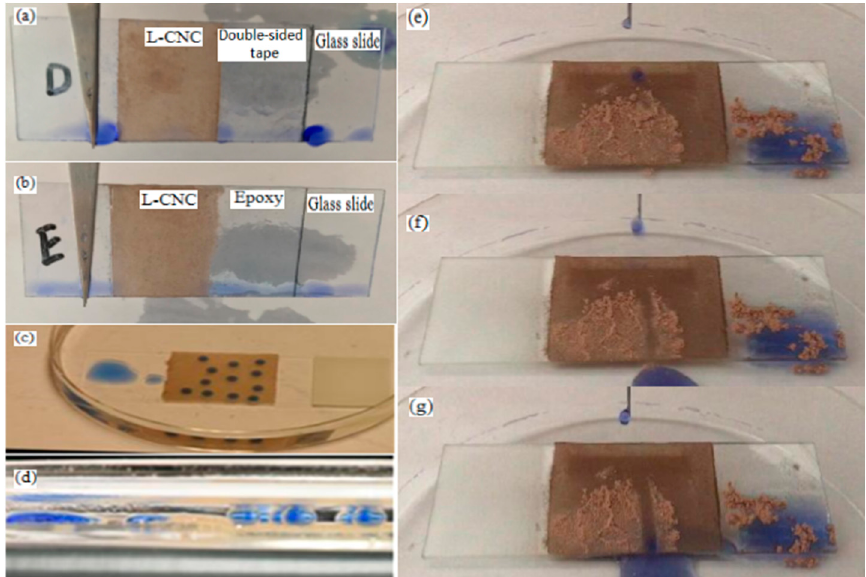
Figure 4. Water repellence properties of ( a ) the D and ( b ) the E coatings; status of the water droplets on the untreated glass slide and the glass slide treated with the D coating from ( c ) a top-down view and ( d ) an eye level view; ( e – g ) the self-cleaning test of the D coating.